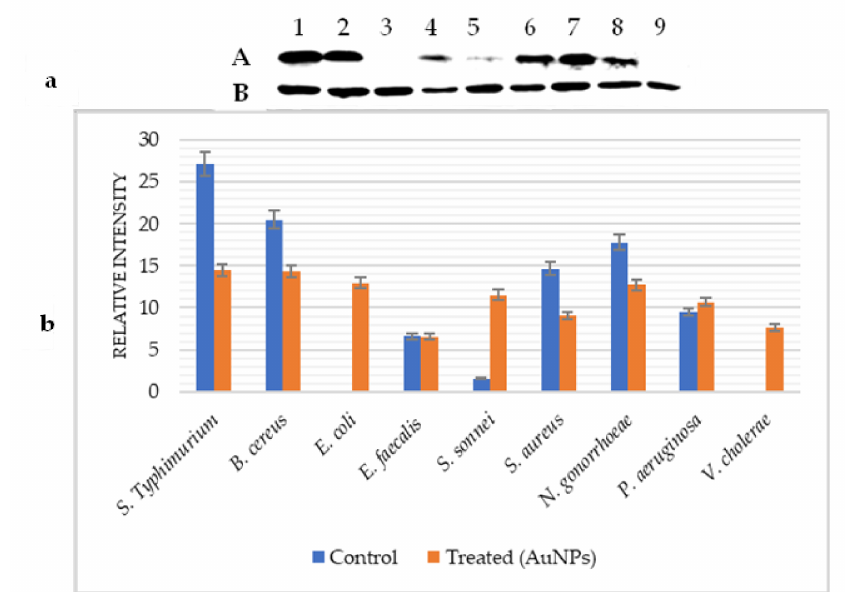
Figure 2. GroES heat shock protein expression under AuNPs effect. ( a ): Western blot analysis; ( b ): Image-J bands quantification; (A): Control; (B): Treated (AuNPs). S. Typhimurium (1), B. cereus (2), E. coli (3), E. faecalis (4), S. sonnei (5), S. aureus (6), N. gonorrhoeae (7), P. aeruginosa (8), and V. cholerae (9).